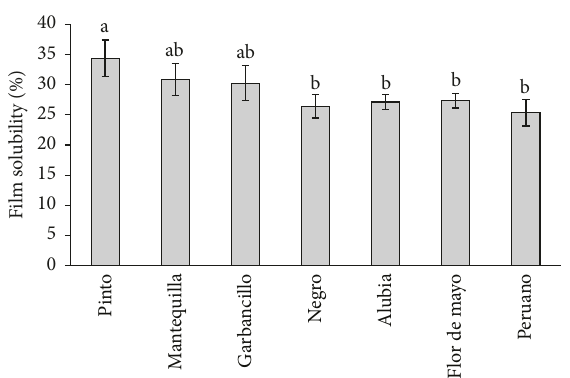
Figure 1: Film solubility of the tested proteinaceous edible films from the studied bean varieties. Means with the same letter are not significantly ( 𝑝 > 0.05 ) different.